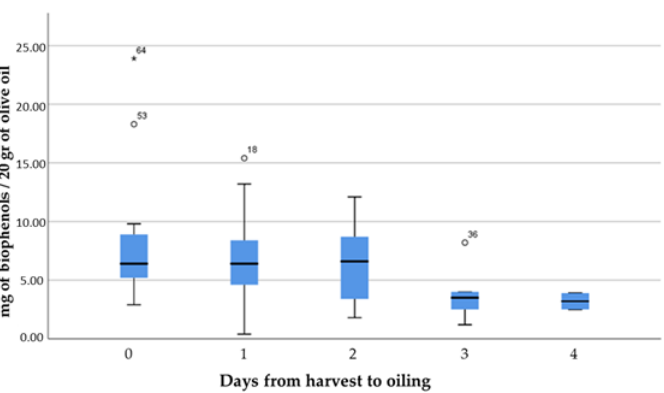
Figure 6. Comparison of biophenol concentrations with the time interval between harvest and oiling in days.